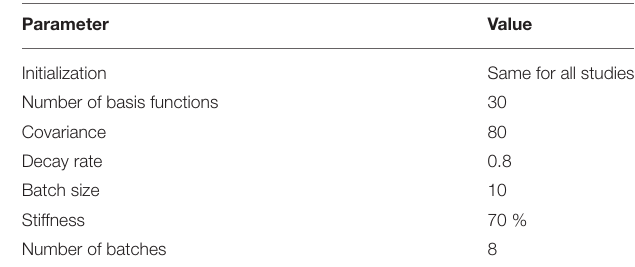
TABLE 1 | Overview of the open parameters of the system which influence